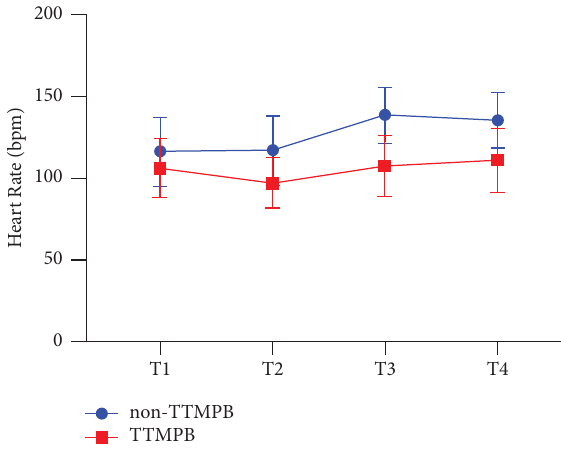
Figure 3: Te heart rate of diferent time points. T1, 10min before TTMPB; T2, skin incision; T3, 1h after surgery; T4, end of surgery. p < 0.001 over time change, p < 0.001 between the two groups, p < 0.001 for interaction. TTMPB: transversus thoracis muscle plane block.